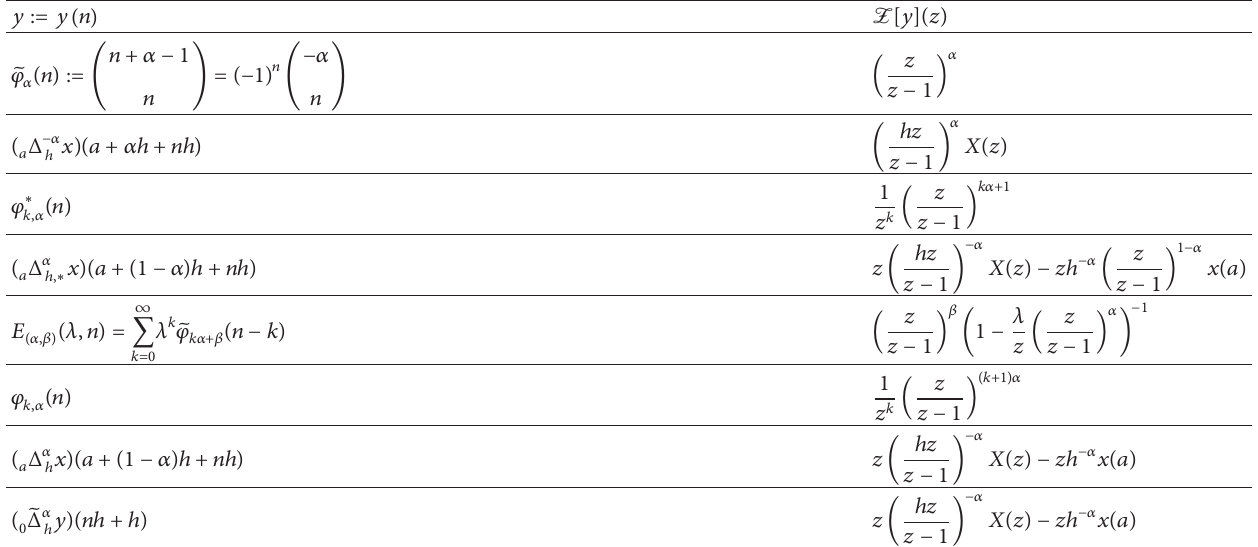
Table 1: Basic Z -transform formulas used in the